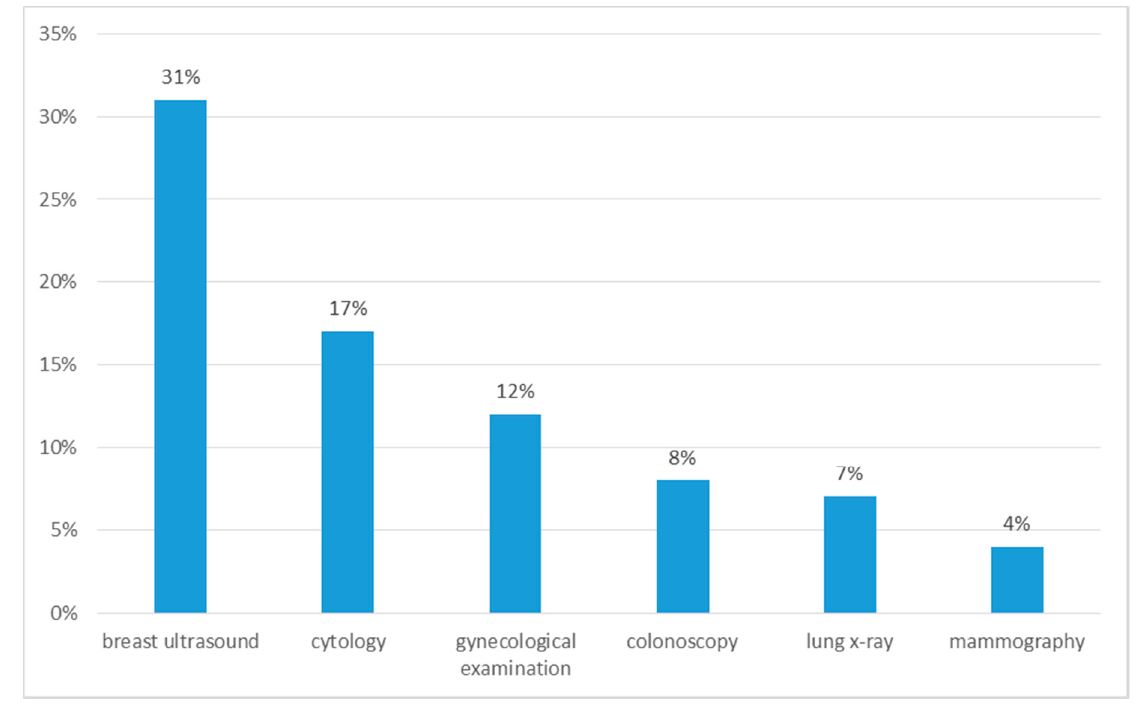
Figure 1. Preventive examinations performed by patients before